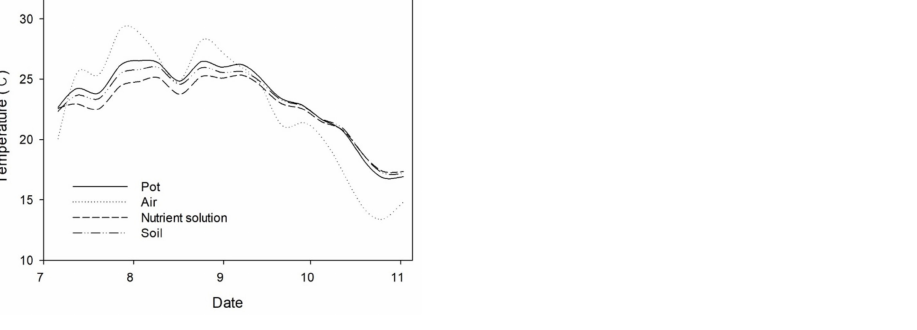
Figure 4. Temperature changes in the pot, nutrient solution, and soil of the hydroponics system and inside the greenhouse during the experimental